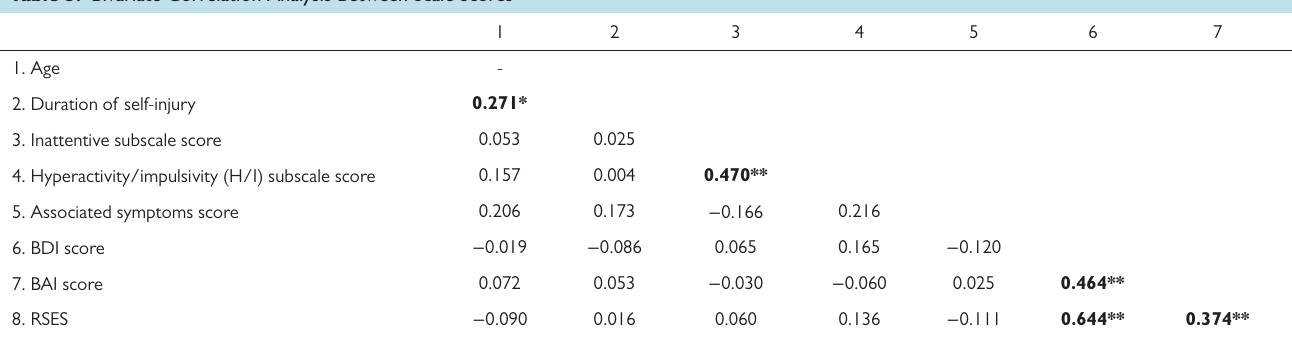
Table 3. Bivariate Correlation Analysis Between Scale